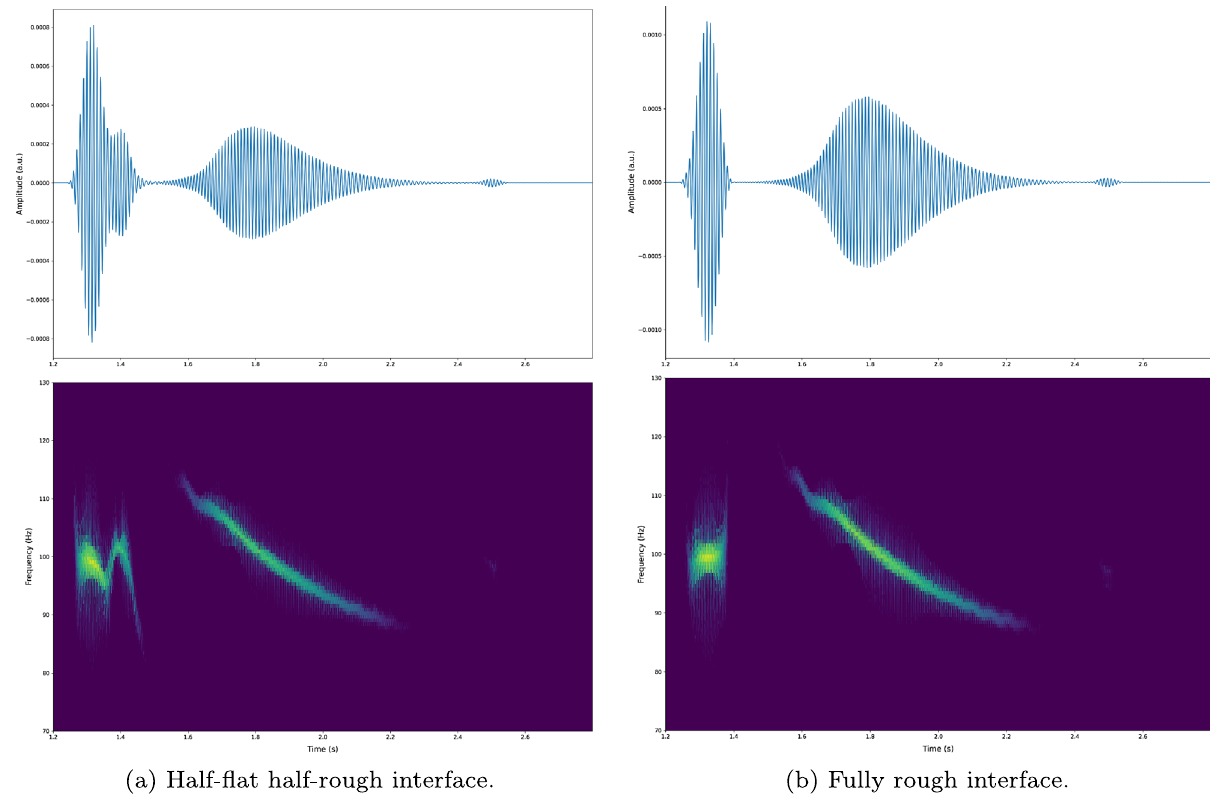
Figure 6. (Top) Signal (trace 276) received at the 276th receiver ( x = 1500 m) and (bottom) associated reassigned spectrogram, for the case of a half- fl at half-rough interface (left) and for a fully rough interface (right). The receiver is exactly vertical to the